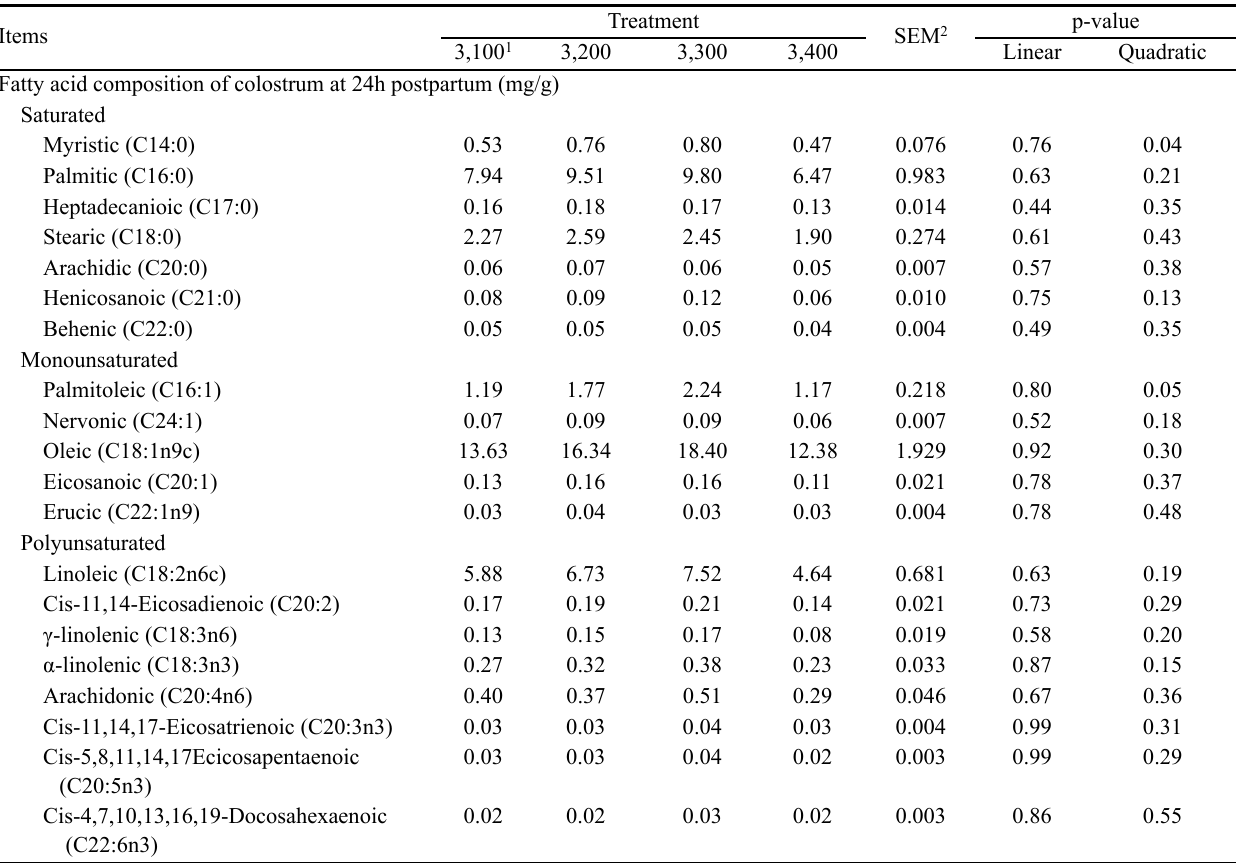
Table 6. Effects of dietary energy level in gestating sows on the fatty acids composition of colostrum in primiparous lactating sows (mg/g)